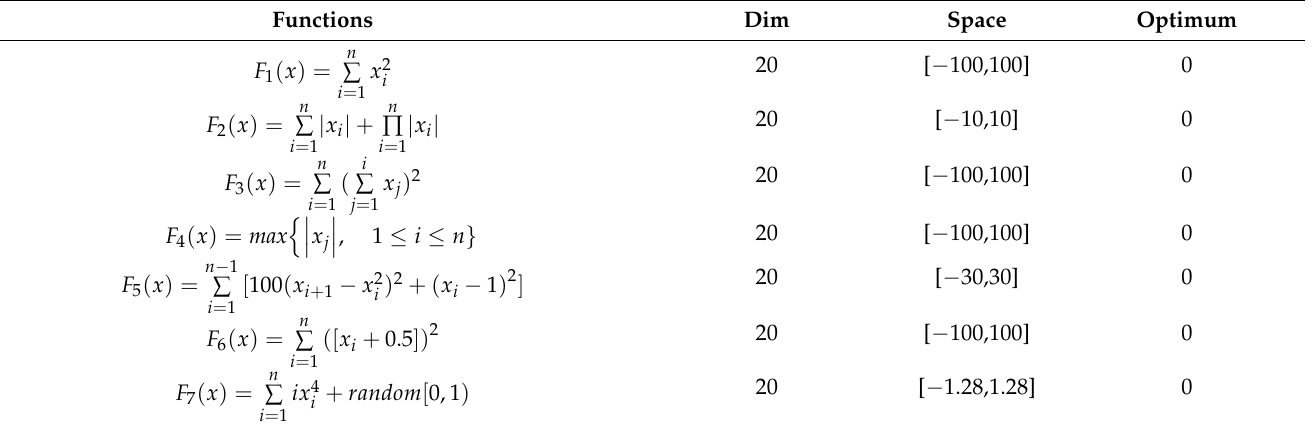
Table 1. Unimodal benchmark